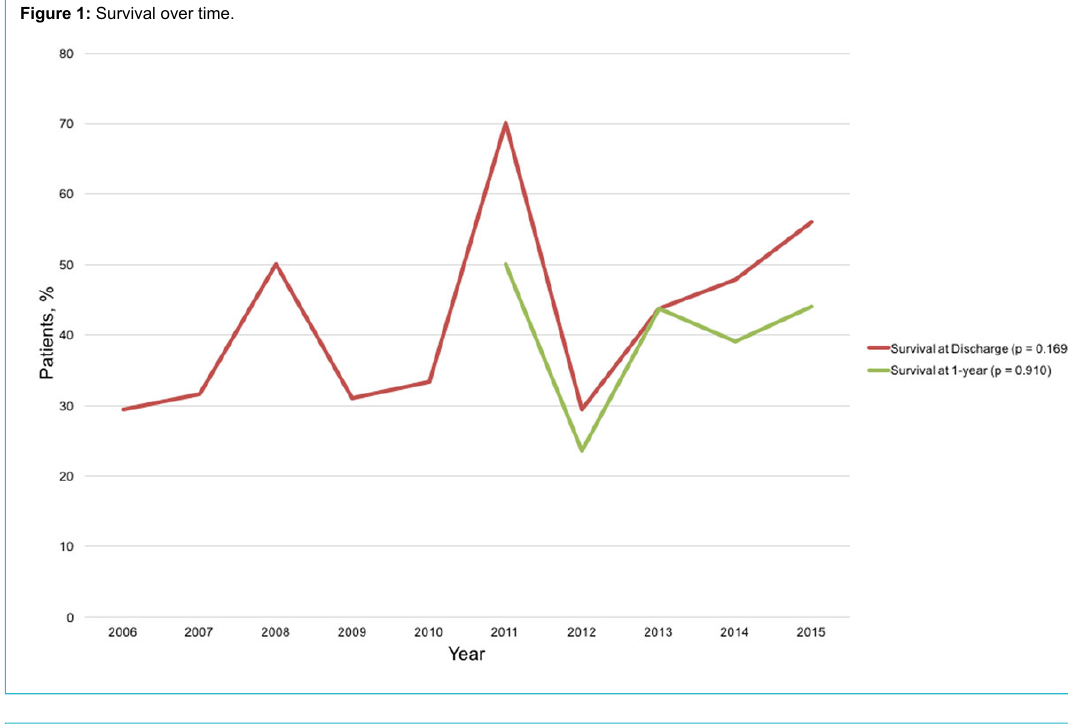
Figure 2: Cerebral Performance Category over